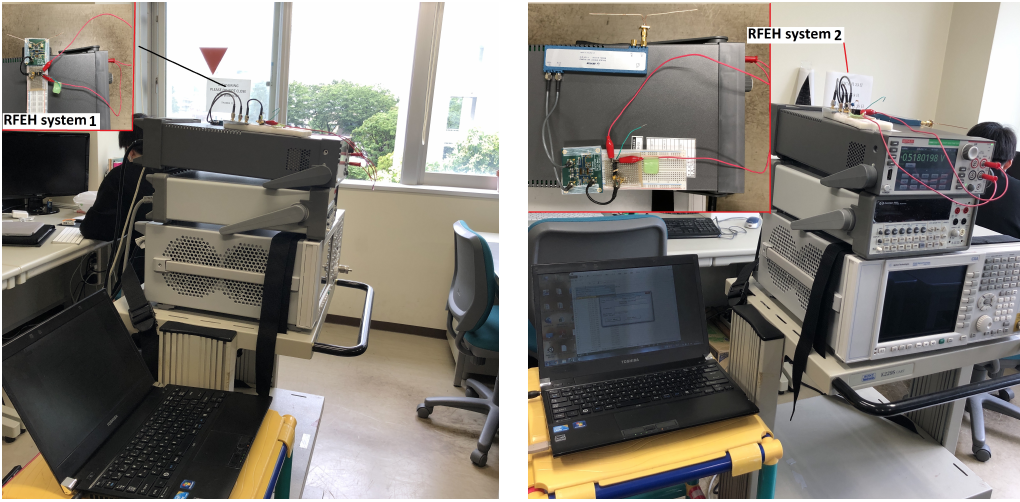
Figure 19. Measurement condition in the office room.